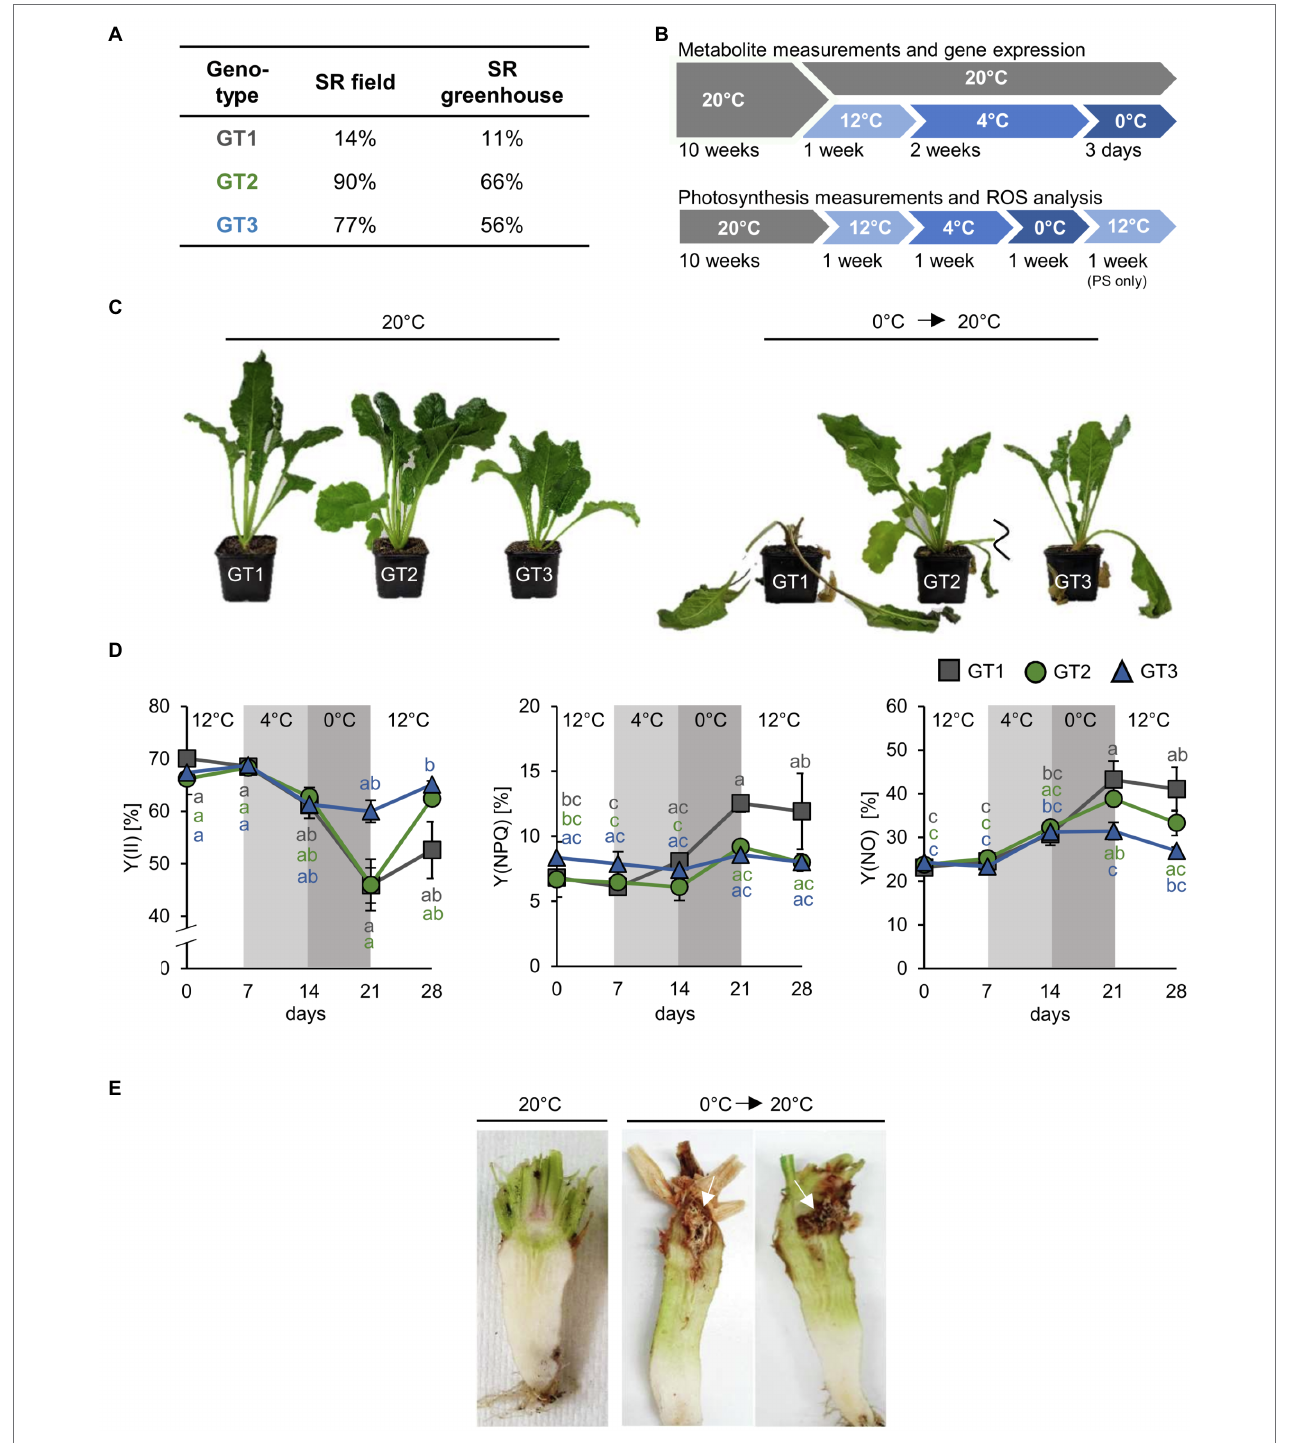
FIGURE 1 | Responses of sugar beet genotypes to freezing temperatures. (A) Freezing survival rates (SR) of three analyzed sugar beet cultivars GT1, GT2, and GT3 measured under field ( n = 100) and greenhouse ( n = 50) conditions given in percent of survived plants. (B) Experimental setup for metabolite and photosynthesis measurements. Plants were grown at 20 ° C for 10 weeks. Subsequently, plants were kept at 20 ° C (control) or transferred to low temperature acclimation conditions (12 ° C and 4 ° C). After 4 ° C treatment, air temperature in the growth chamber was lowered and plants were harvested as the soil temperature was 0 ° C or below. (C) Typical appearance of sugar beet plants of GT1, GT2, and GT3 before and after freezing treatment. (D) PAM measurements were performed on leaves of the three different genotypes under cold and freezing conditions, as well as during a post-freezing recovery phase at 12 ° C. For this, air temperature was kept at 0 °